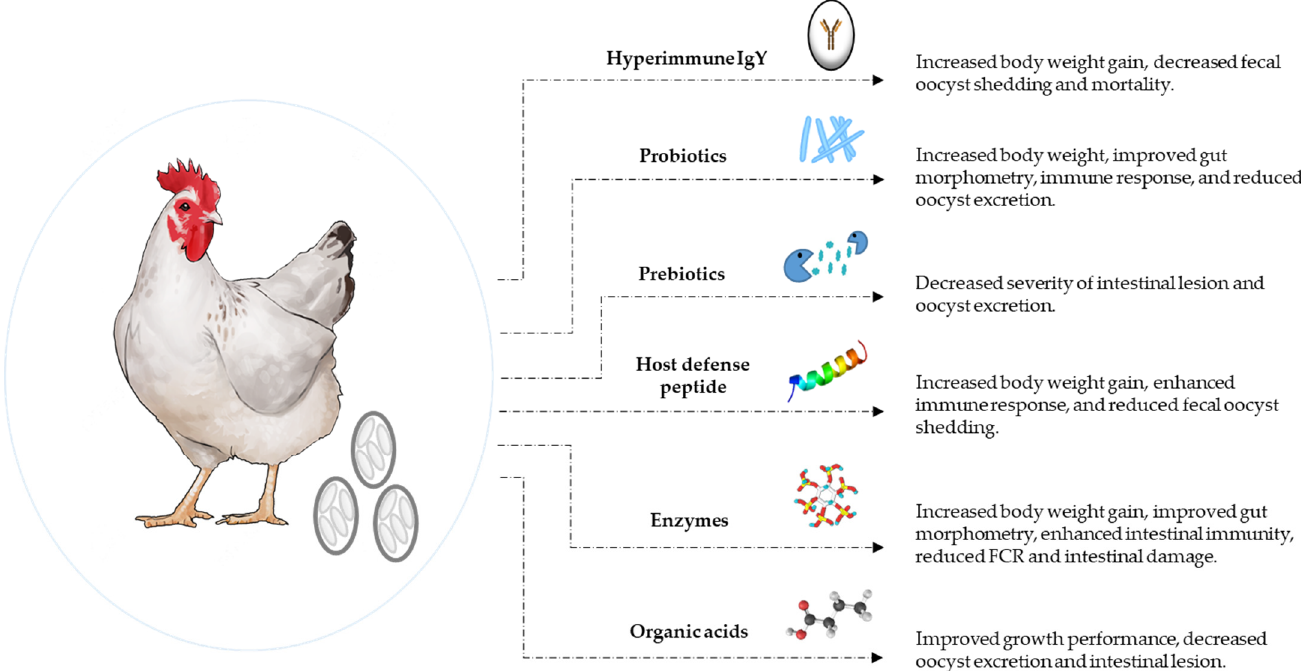
Figure 1. Antibiotic alternatives to control coccidiosis in chickens. Various novel strategies